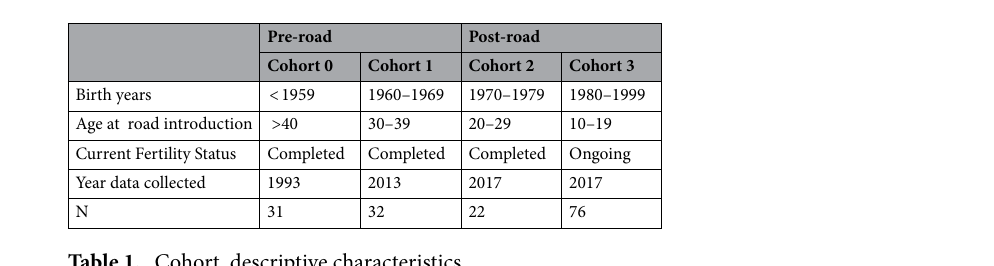
Table 1. Cohort descriptive